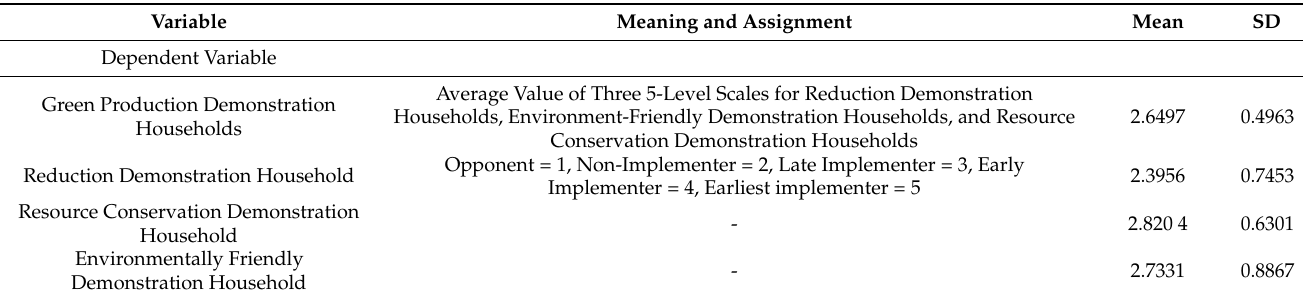
Table 2. Variable Meaning and Basic Situation of